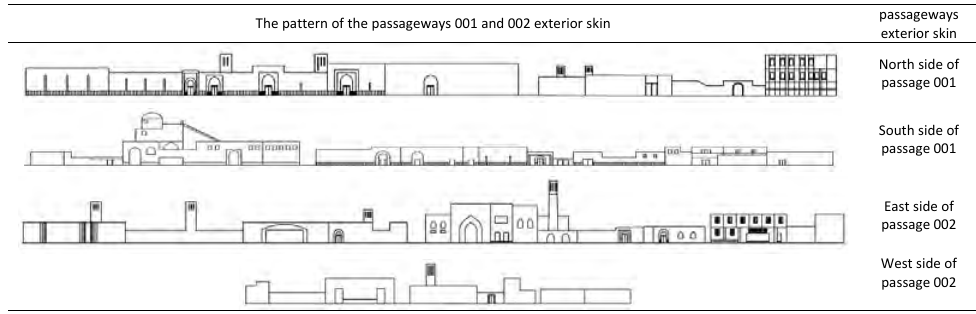
Table 9: The pattern of passageways exterior skin in Sahl Ibn Ali district of Yazd